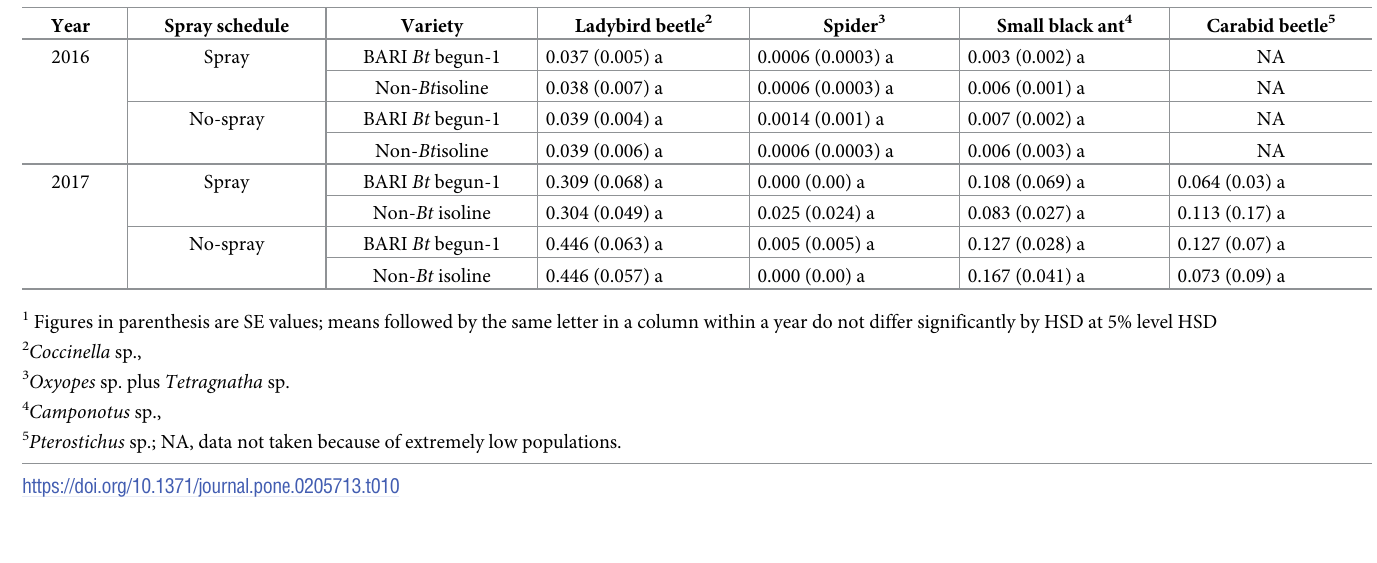
Table 10. Mean abundance 1 of non-target beneficial arthropods (No./trap) recovered from yellow sticky traps in brinjal relative to insecticides and varieties, OFRD, BARI, Bogra,